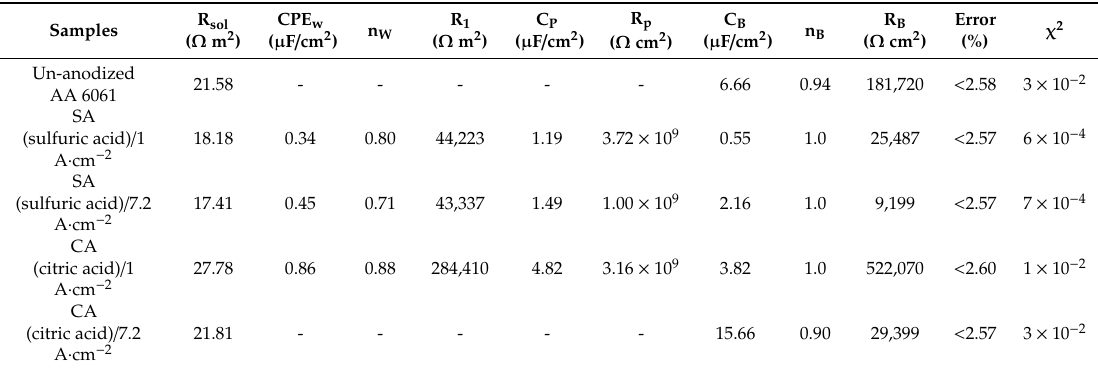
Table 4. Electrochemical impedance spectroscopy (EIS) data obtained by equivalent electric circuit simulation of the un-anodized AA 6061 and anodized samples at di ff erent conditions exposed in 3.5 wt.% NaCl